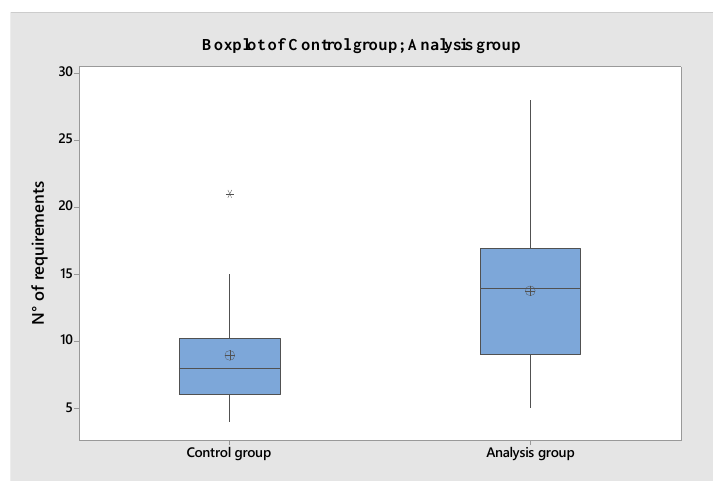
Figure 3. Boxplot of the number of requirements produced by the different groups of subjects.